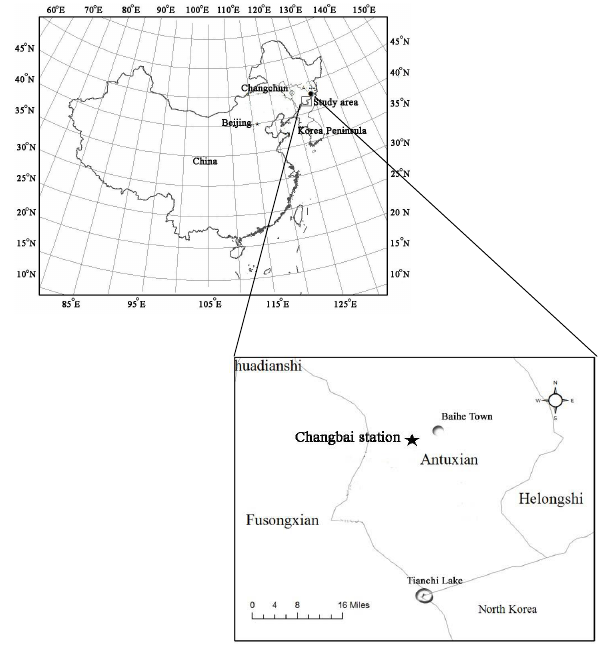
Fig.1. Location of Changbai station in northeastern China Fig. 1. Location of Changbai station in northeastern